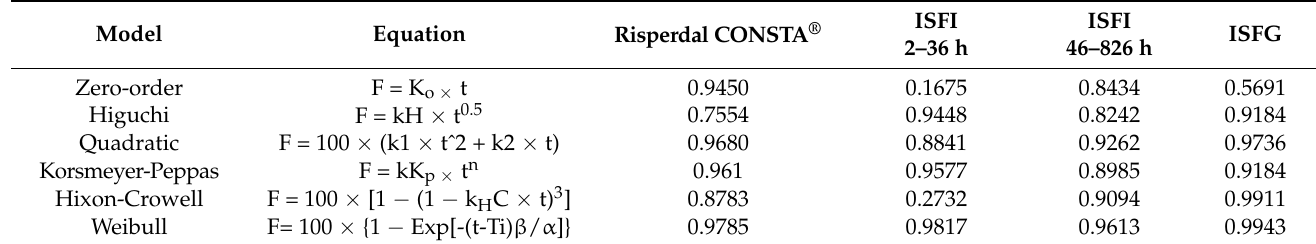
Table 1. Regression coefficient (R 2 ) of mathematical